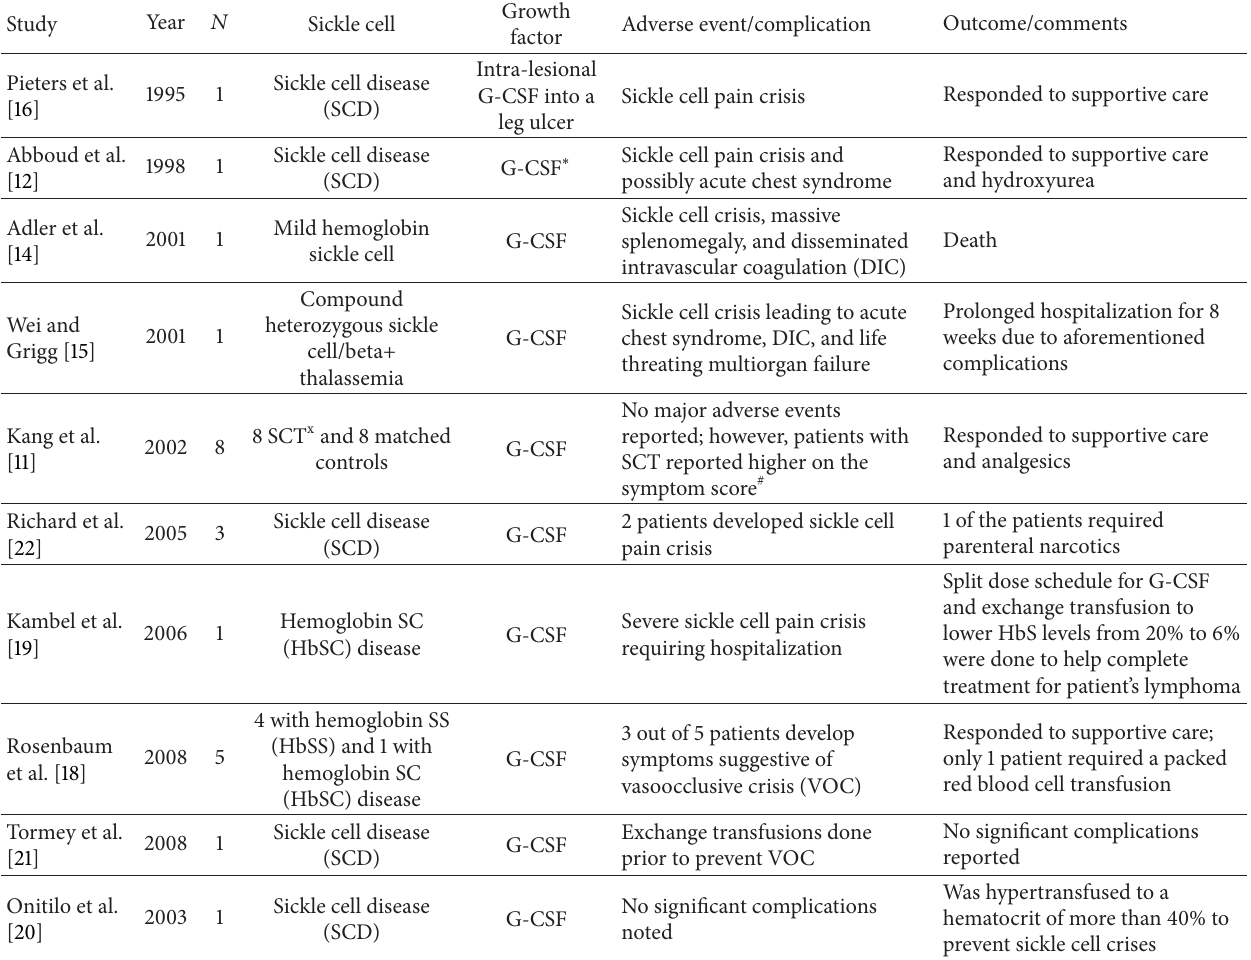
Table 1: Summary of other similar cases of sickle cell crises reported in patients receiving colony stimulating factors [17] + . Study